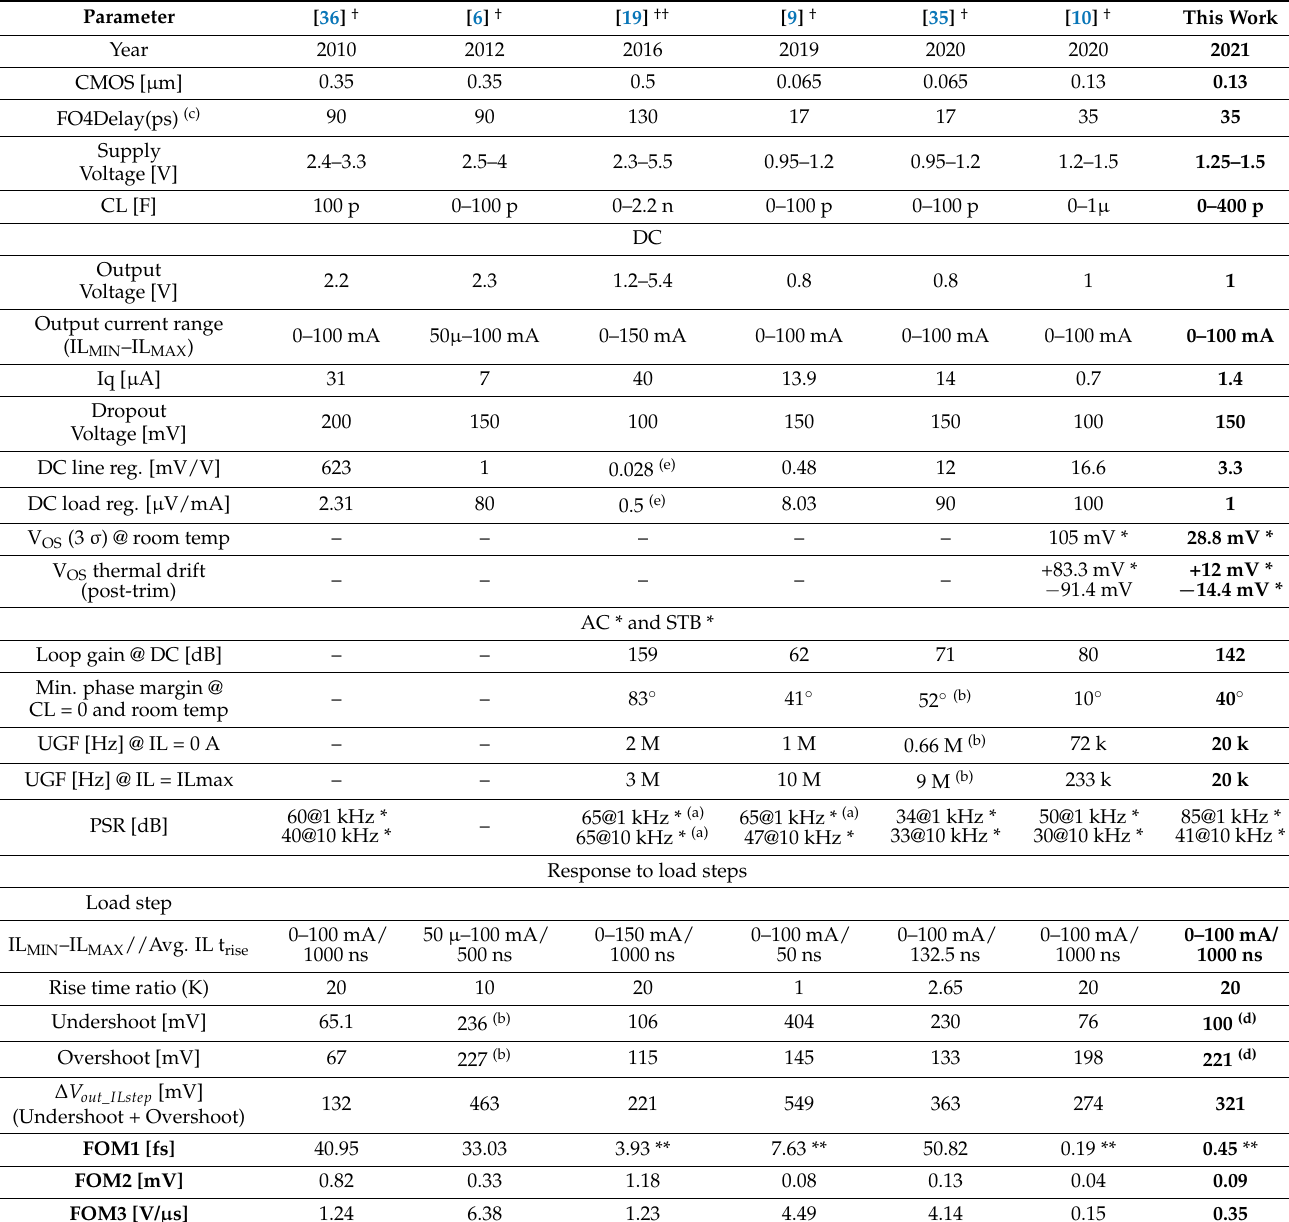
Table 3. Performance